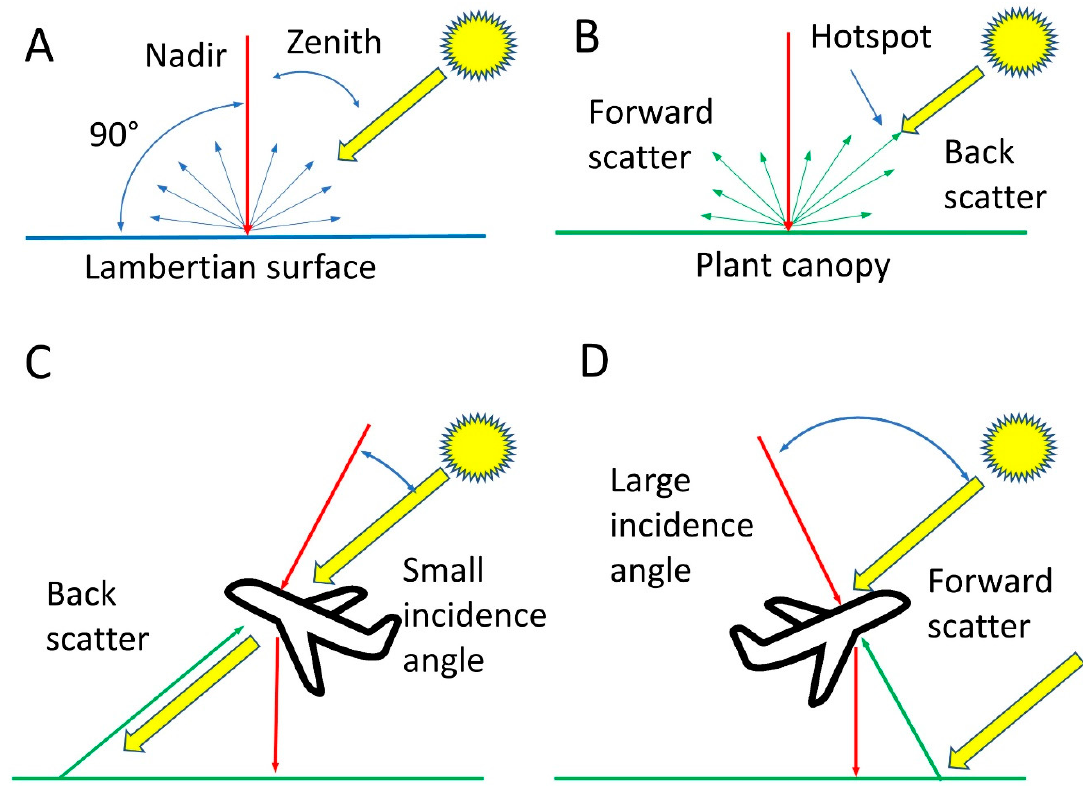
Figure 7. Bidirectional Reflectance Distribution Functions (BRDF) for ( A ) a Lambertian surface and ( B ) a plant canopy. E ff ect of plane attitude on an up-looking ILS when ( C ) flying away from the sun and ( D ) flying towards the sun. The red lines in ( A ) and ( B ) are pointing perpendicular to level ground and defining the nadir direction. The zenith angle is the direction between the nadir and the sun’s position and is the solar incidence angle on a level surface. The two red lines in ( C ) and ( D ) are perpendicular to the top surface of the aircraft and nadir view for a sensor. ( C ) shows the orientation for northwest flights on 8 July and ( D ) shows the orientation for southeast